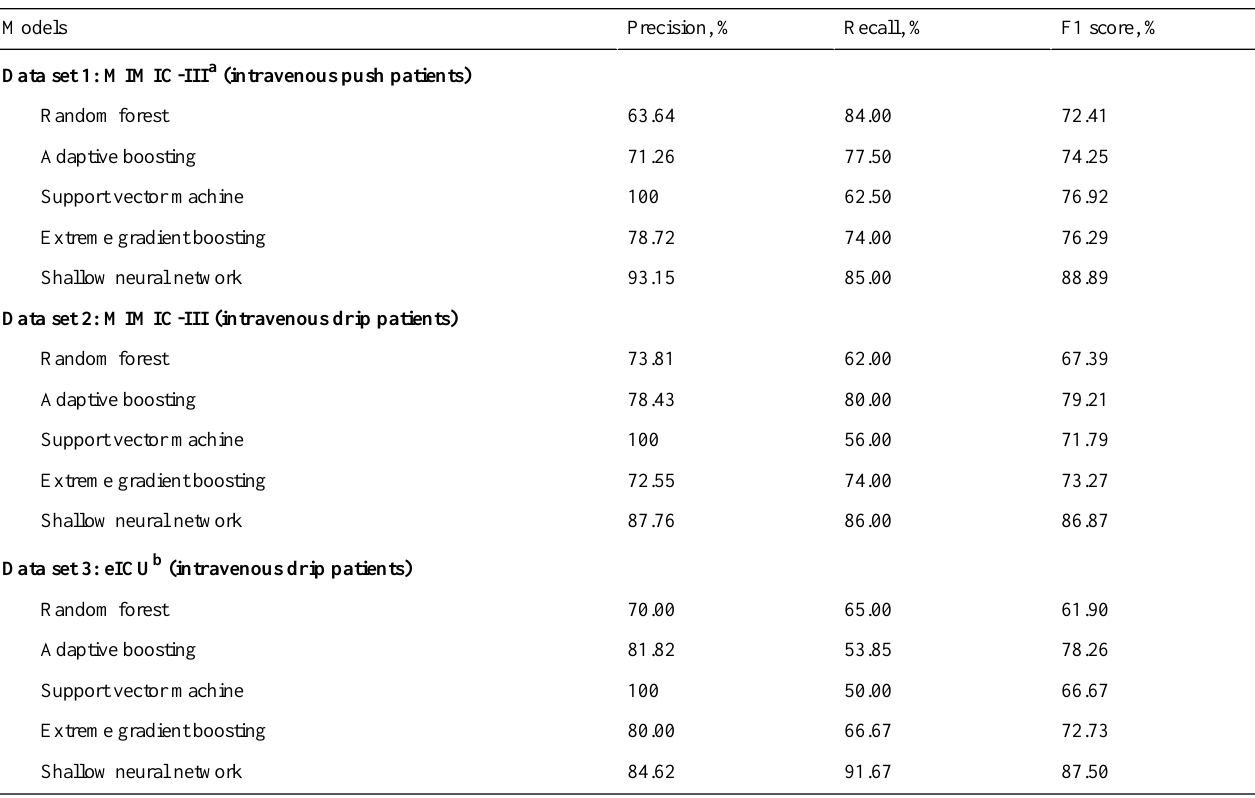
F1 score, %Recall, %Precision, %Models